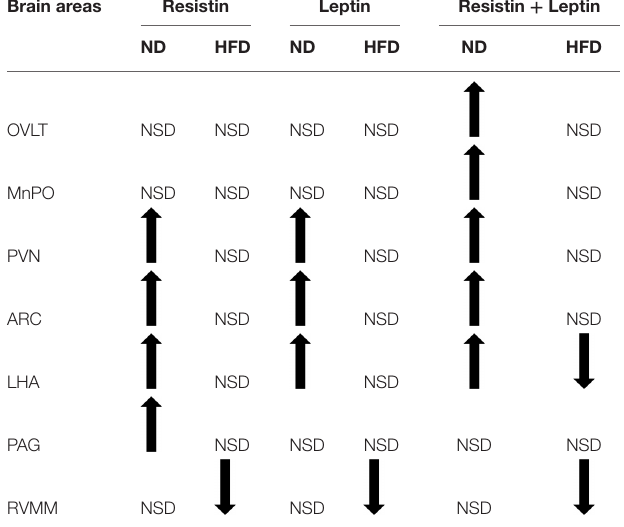
TABLE 1 | Summary of brain regions in which there were changes in the number of Fos-positive cell nuclei compared to control. Brain areas